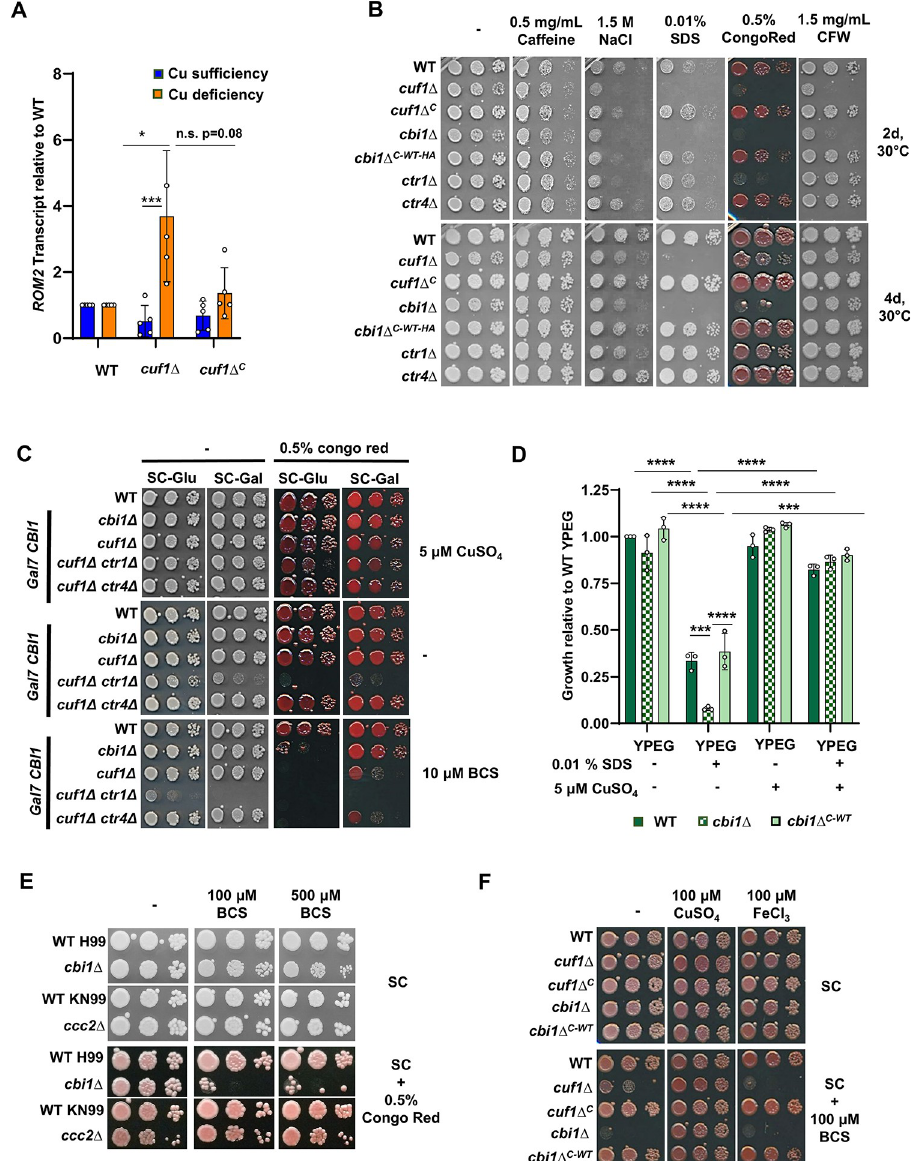
Fig 2. The Cuf1 transcription factor as well as its targets Cbi1 and Ctr1 are involved in maintaining cell wall integrity during copper deficiency. (A) Transcript abundance of the cell wall stress gene ROM2 during copper deprivation. The WT, cuf1 Δ and Cuf1-Flag complemented cuf1 Δ C strains were incubated in either high copper (SC medium with 1 mM CuSO 4 for 1h at 30˚C) or low copper (SC medium with 1 mM BCS for 6h at 30˚C) conditions. Quantitative RT-PCR was used to assess relative ROM2 transcript levels for each strain compared to the WT in each condition. Presented is the mean +/- SEM of the relative transcript levels of 5 biological replicates. A 2-way ANOVA was performed from log transformed data using GraphPad Prism. (B) Growth analysis in presence of cell wall/ surface stressors. Five-fold serial dilutions of cell suspensions for each strain were incubated on SC medium with 100 μ M BCS, supplemented with indicated amounts of cell wall and cell surface stressors. Plates were incubated at 30˚C for 2-4d, and the figure shows a representative image from 3 independent experiments. (C) GAL7 promoter-driven expression of Cbi1 in different mutant strain backgrounds during cell wall stress. Five-fold serial dilutions of cell suspensions for each strain were incubated on SC medium with indicated copper concentrations, in the presence or absence of the cell wall stressor Congo red, on SC medium with either glucose (SC-Glu) ( CBI1 -repressing conditions) or galactose (SC-Gal) ( CBI1 -inducing conditions) as carbohydrate source. Plates were incubated at 30˚C for 3d. This figure shows a representative image from 3 independent spotting experiments. (D) The WT, cbi1 Δ , and cbi1 Δ ( cbi1 Δ C-WT ) complemented strains were incubated in YP medium with the non-fermentable carbon sources ethanol and glycerol (YPEG) in presence and absence of the cell wall stressor SDS, and with or without the addition of 5 μ M CuSO 4